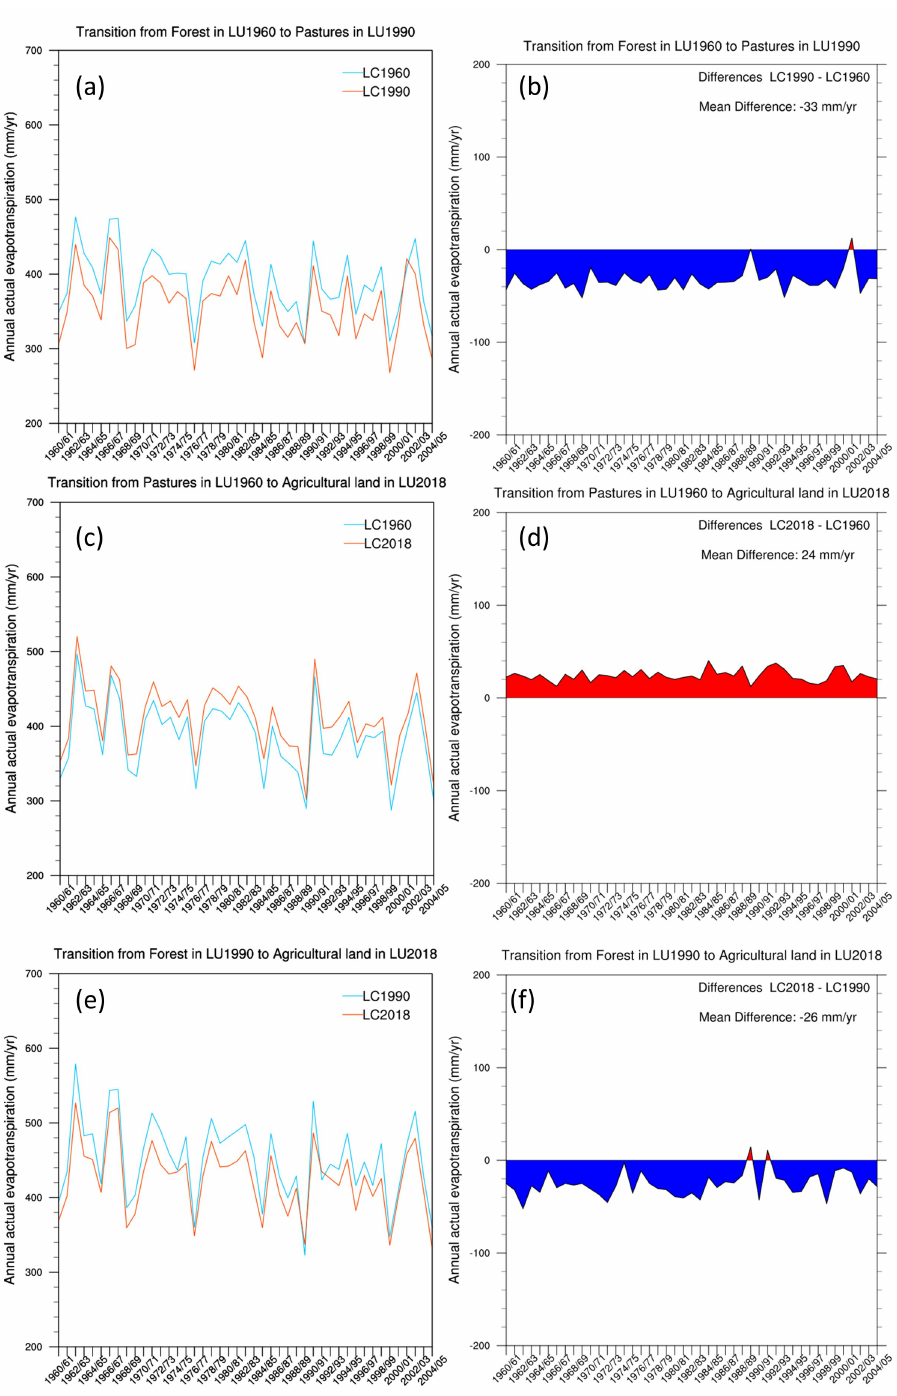
Figure 9. Timeseries, regarding areas characterized by transition from forest in 1960 to pastures in 1990, of ( a ) annual actual evapotranspiration (mm / yr) simulated by LC1990 (orange line) and LC1960 (blue line) as well as ( b ) their di ff erences (red for positive and blue for negative). The same for ( c , d ) as well as ( e , f ) regarding transition from pastures in 1960 to agricultural land in 2018 and transition from forest in 1990 to agricultural land in 2018,